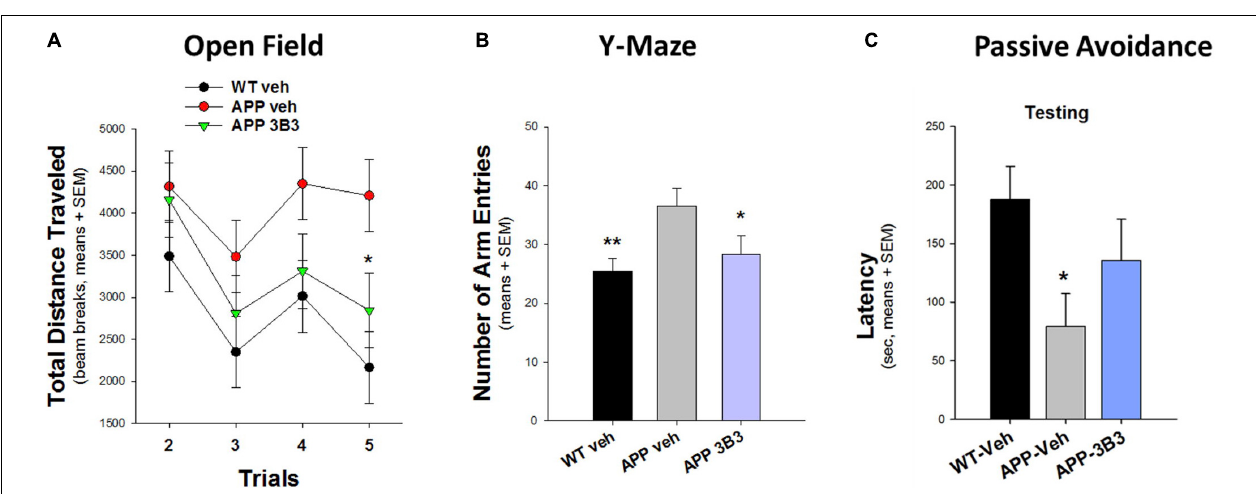
FIGURE 10 | ACU3B3 treatment at 20 mg/kg in 5- to 7-month-old Thy1-hAPP/SL mice ( n = 13–14/group, means + SEM). (A) Open field total distance measurement, APP-Veh vs. APP-3B3, * p = 0.029. (B) Y-maze arm entries, APP-Veh vs. APP-3B3, * p = 0.045; APP-Veh vs. WT-Veh, ** p = 0.007. (C) Passive avoidance latency, APPSL-APP3B3 vs. APPSL-Veh trended for drug effect, but was not statistically significant (Dodart et al.,